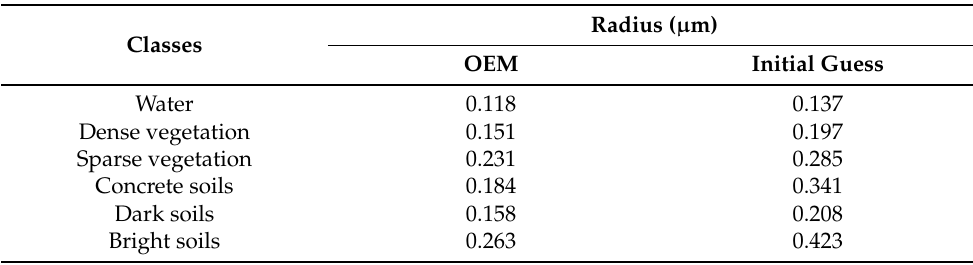
Table 5. Mean radius ( µ m) by class of soil, retrieved with the OEM methods and from the initial guess inside the final plume